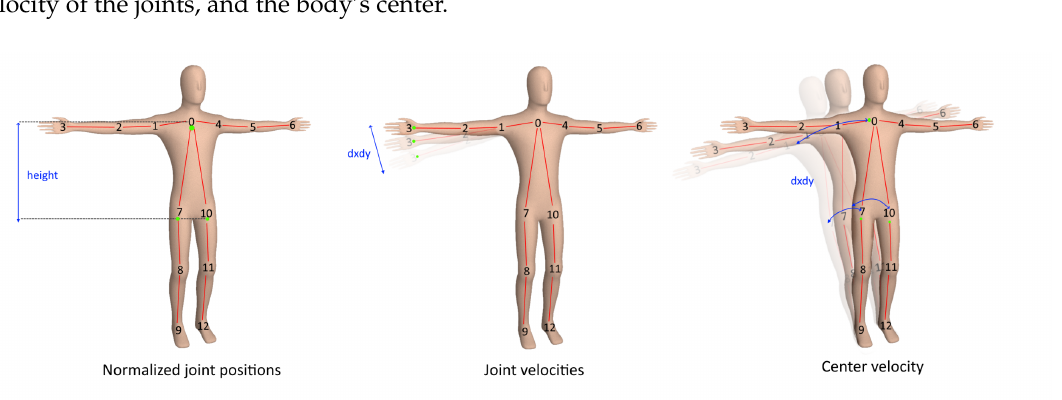
Figure 7. Representation of the extracted features. Joint positions (normalized), velocity, and body velocity are used as features for the